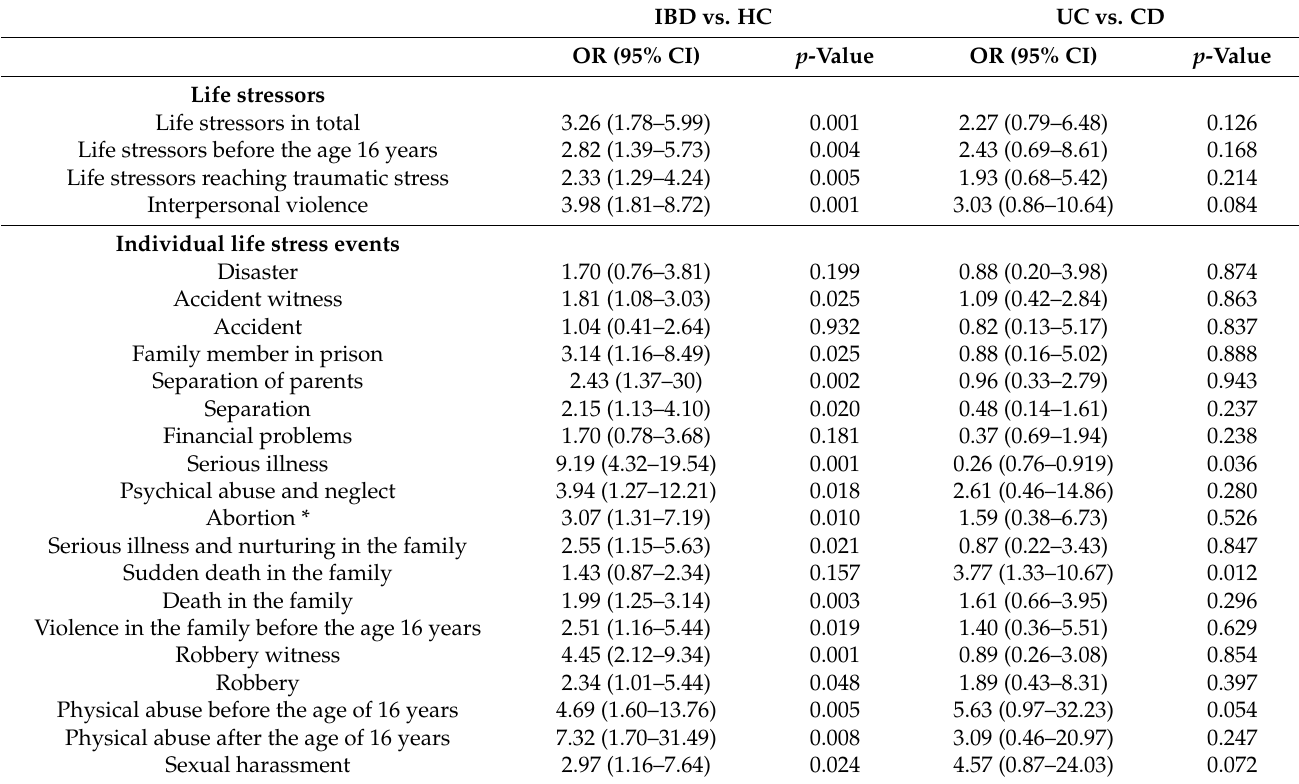
Table 2. Odds of being in the IBD group, depending on the occurrence of life stressor events. Results of binary logistic regression models with the reference category HC, adjusted for age and gender. In the second column, odds of being in the UC group, depending on the occurrence of life stressors events, with the reference category CD